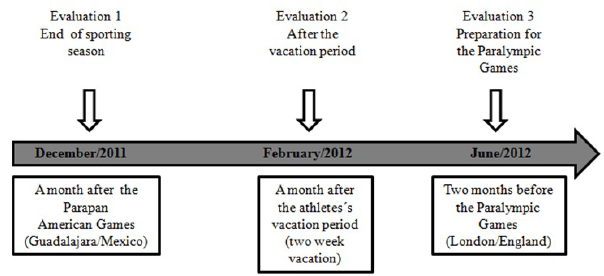
Figure 1. Experimental Design of the Study